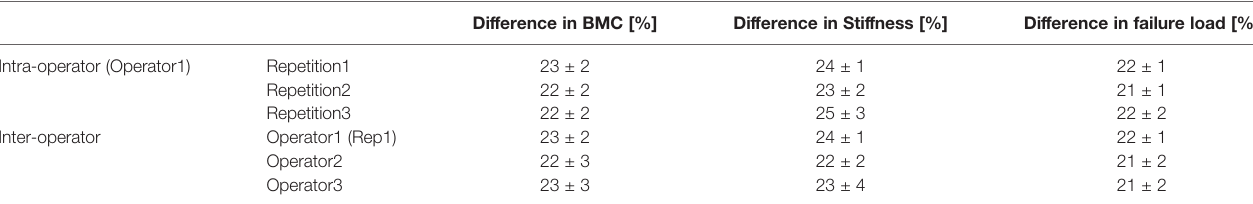
TABLE 4 | Variations between week 18 (pre-treatment) and week 22 (after 5 weeks of PTH injections) of age measured in different repetitions and by different operators (average ± standard deviation, N = 5).